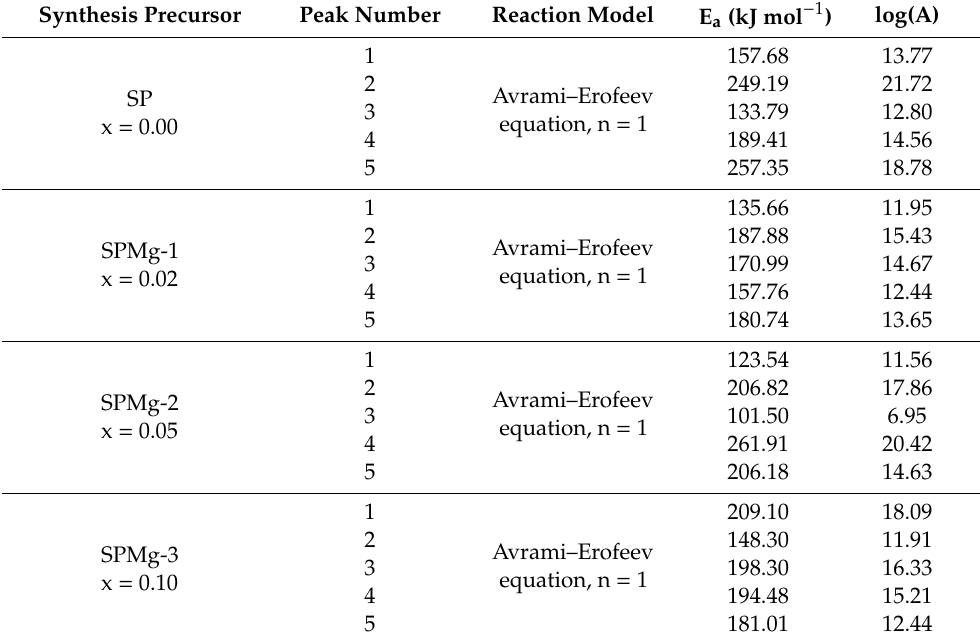
Table 2. Reaction models and kinetic parameters of each single reaction of polymeric matrix decomposition process of precursors with di ff erent magnesium doping